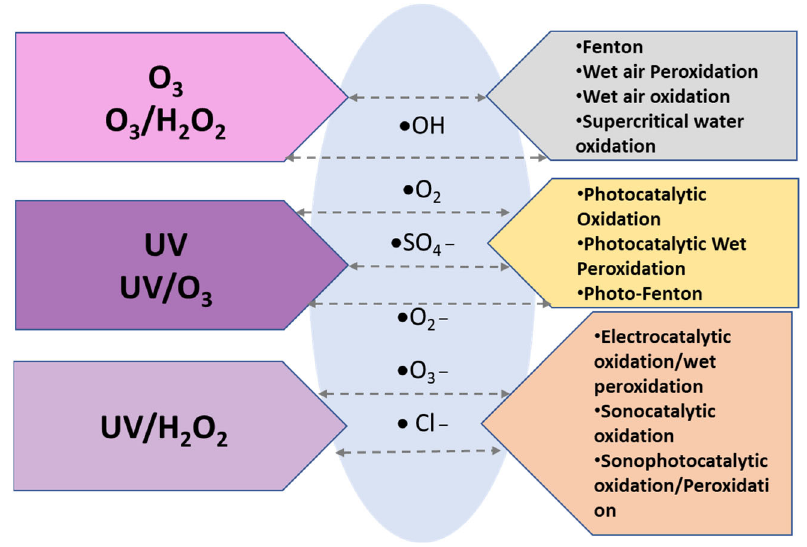
Figure 1. Various AOP